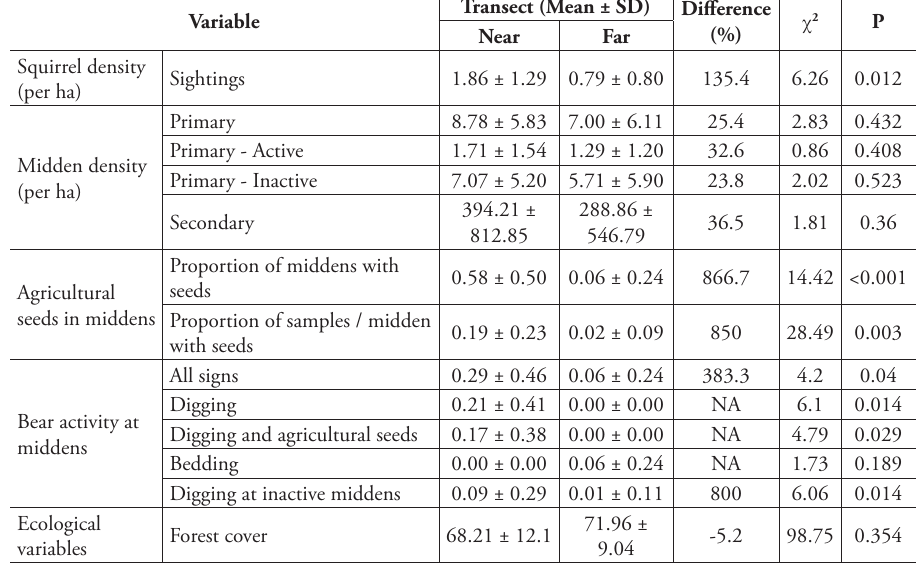
Table 1. Mean ± SD of squirrel sightings, middens, midden samples containing agricultural products, middens with evidence of bear activity, and forest cover measured on 14 pairs of 500 m transects posi- tioned near (< 50 m) and far (≈ 200 m) from the rail in Banff and Yoho National Parks in 2014. The differences between transect means are reported as ([near – far] / far * 100) with their significance assessed via generalized linear models using the best-fitting distribution with transect location as the single predic- tor